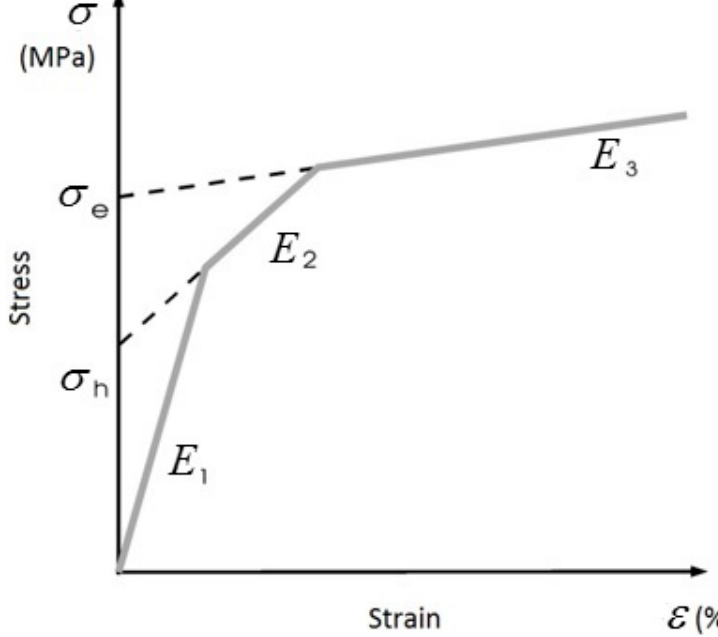
Figure 3. Trilinear elastic–plastic model of the material.